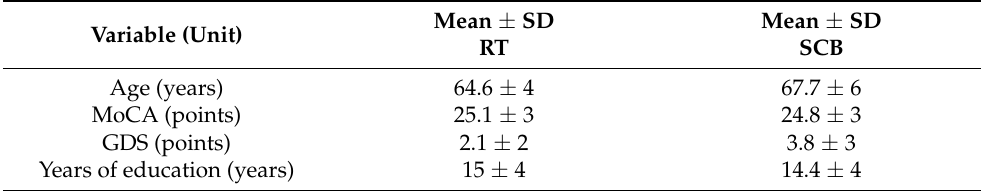
Table 1. Group’s description before physical